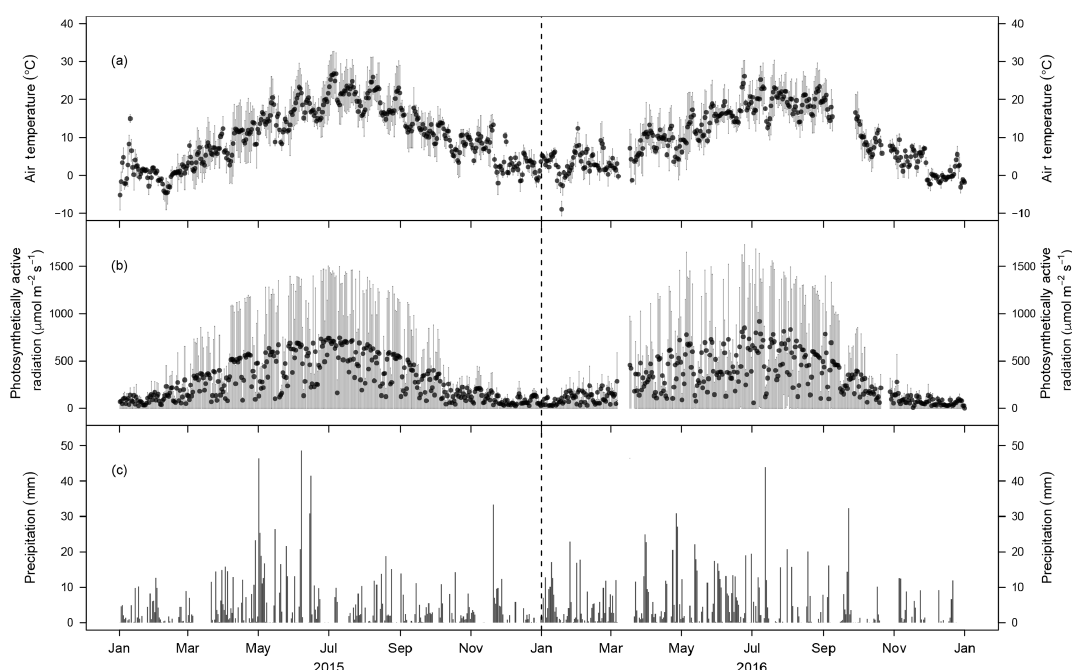
Figure 2. Meteorological conditions during 2015 and 2016. (a) Average daily air temperature (2m) and (b) average daily photosynthetically active radiation (2m). The grey bars indicate the sub-daily variability (quartiles based on 10min values). (c) Daily precipitation sums during 2015 and 2016